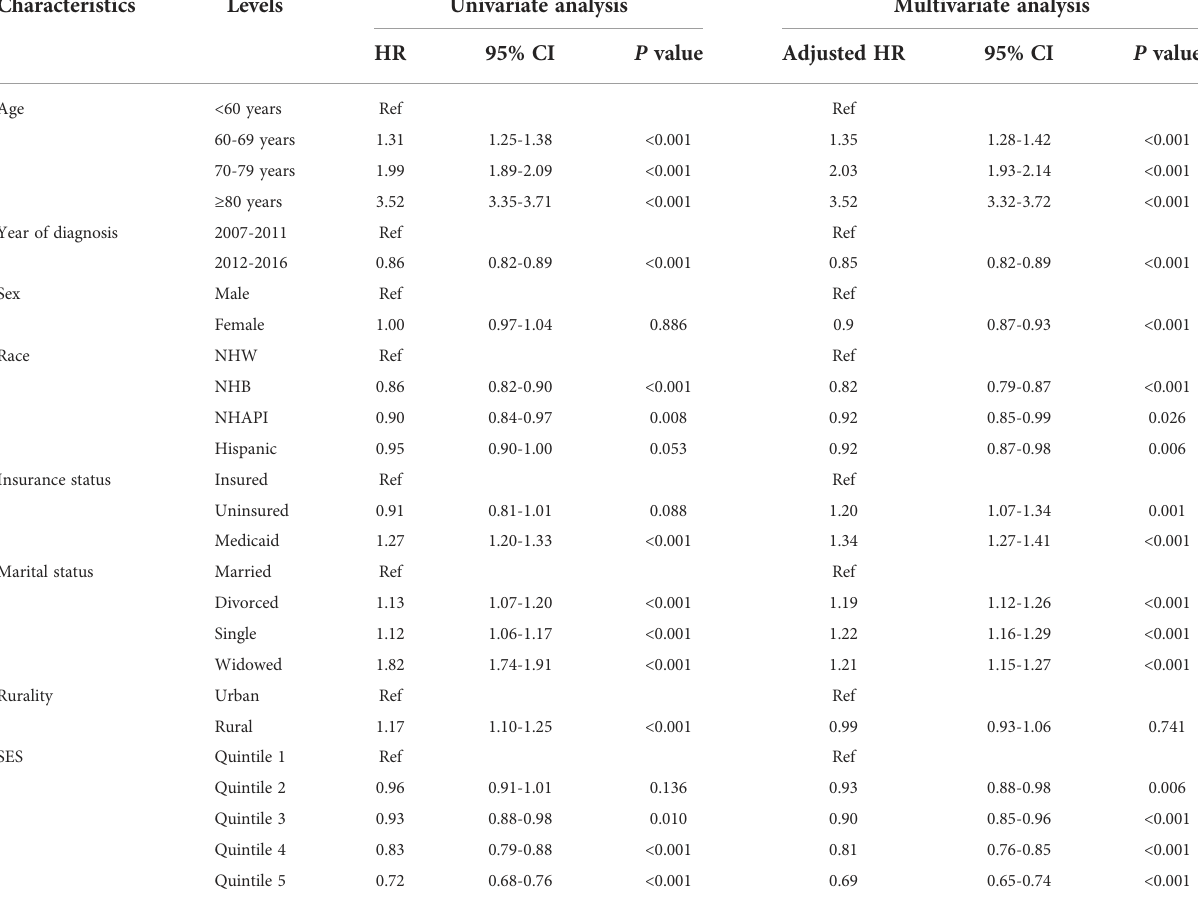
TABLE 3 Univariate and multivariate Cox regression analysis for MSS in the SEER cohort.